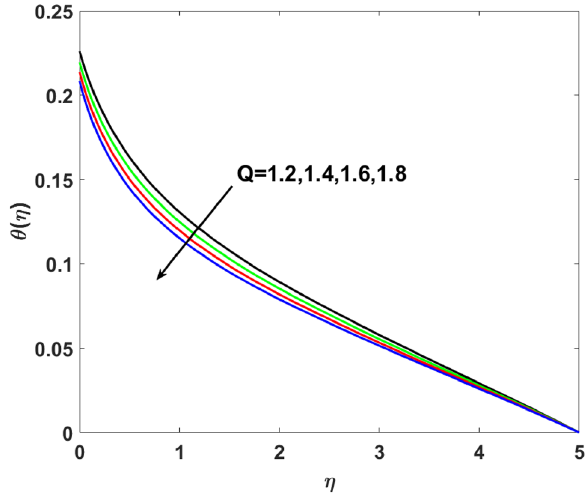
Figure 8. θ(η) versus Q > 0 .